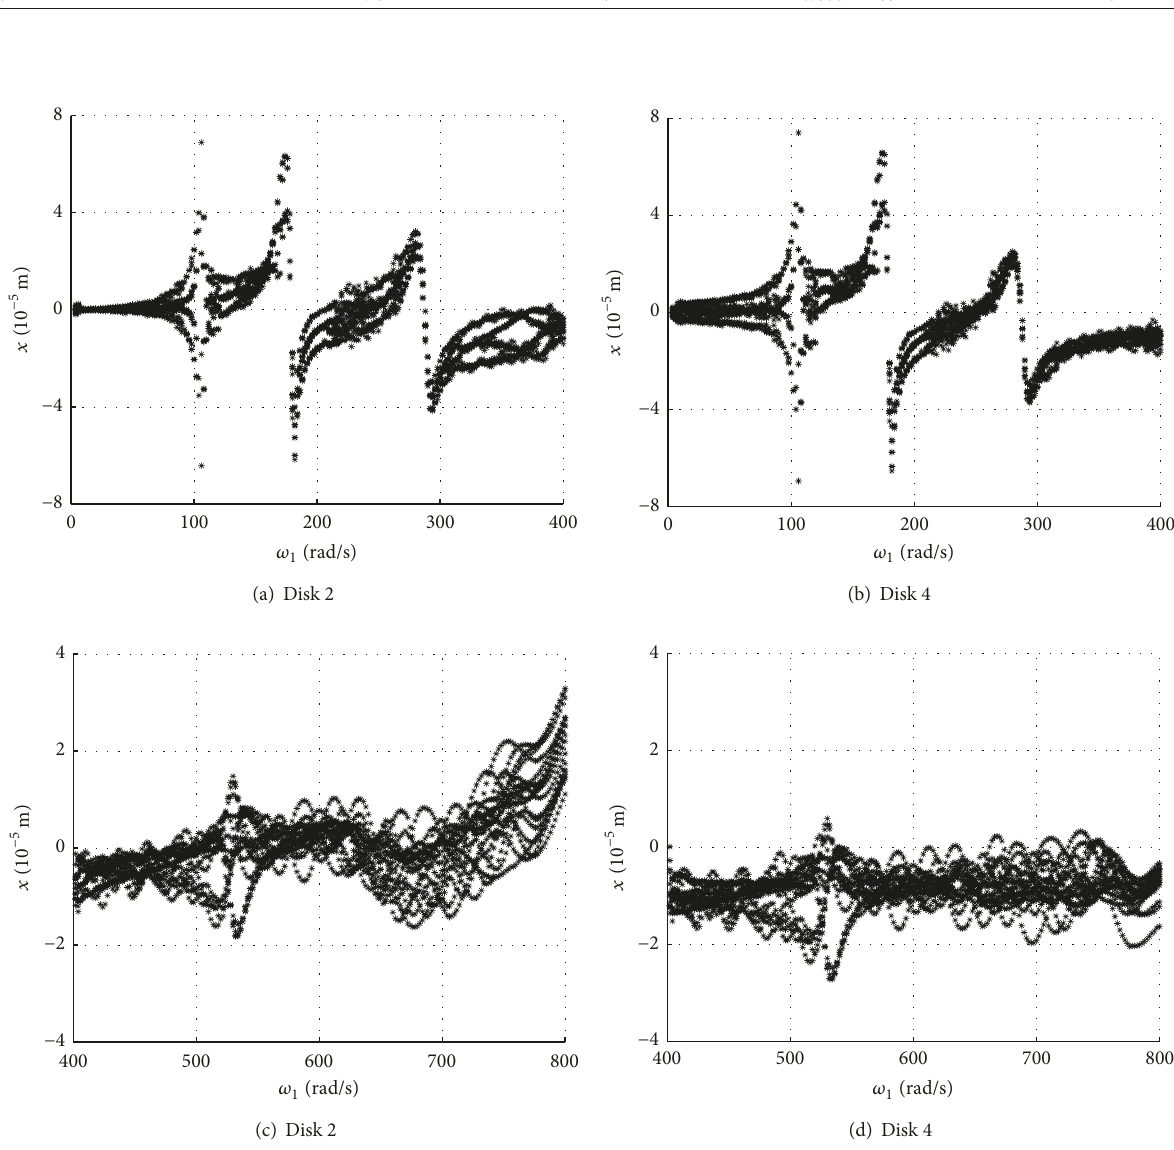
Figure 9: Bifurcation diagrams of the horizontal response of disk 2 and disk 4 with rotor speed. 𝜆 = 1.65 .